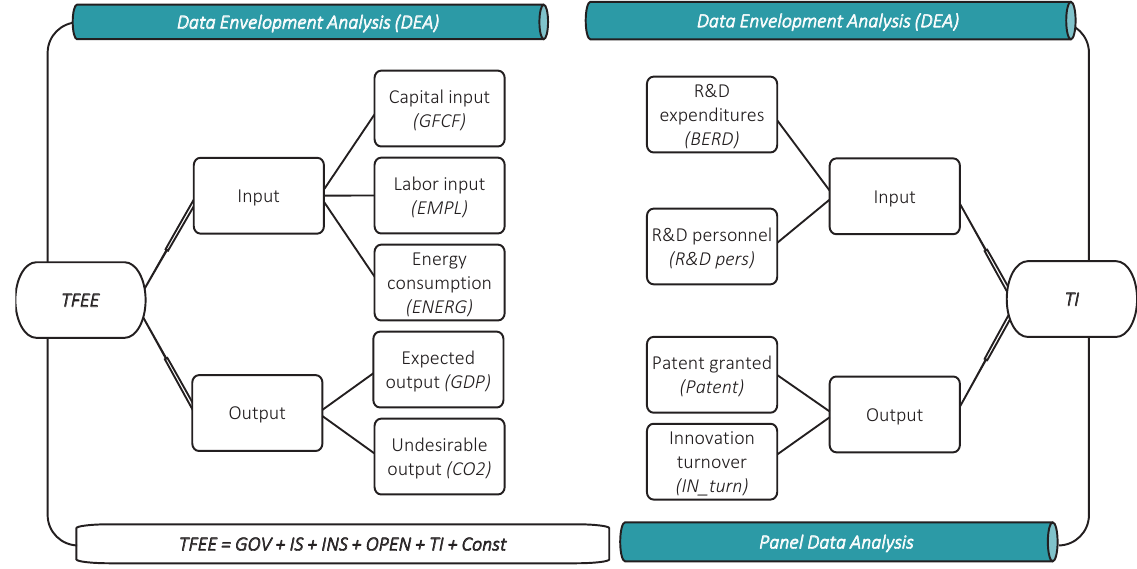
Figure 2. Relationship between total factor energy efficiency (TFEE) and technological innovation